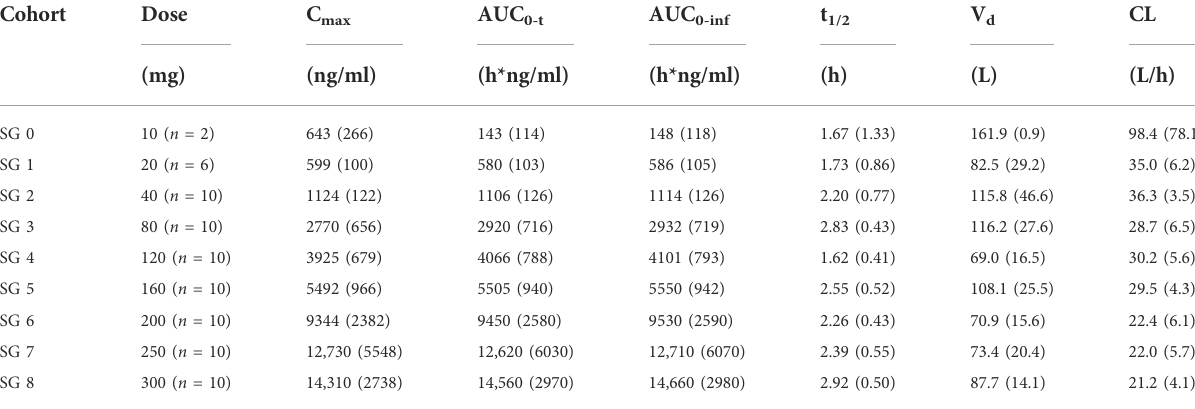
TABLE 2 Pharmacokinetic parameters in the single ascending dose study.